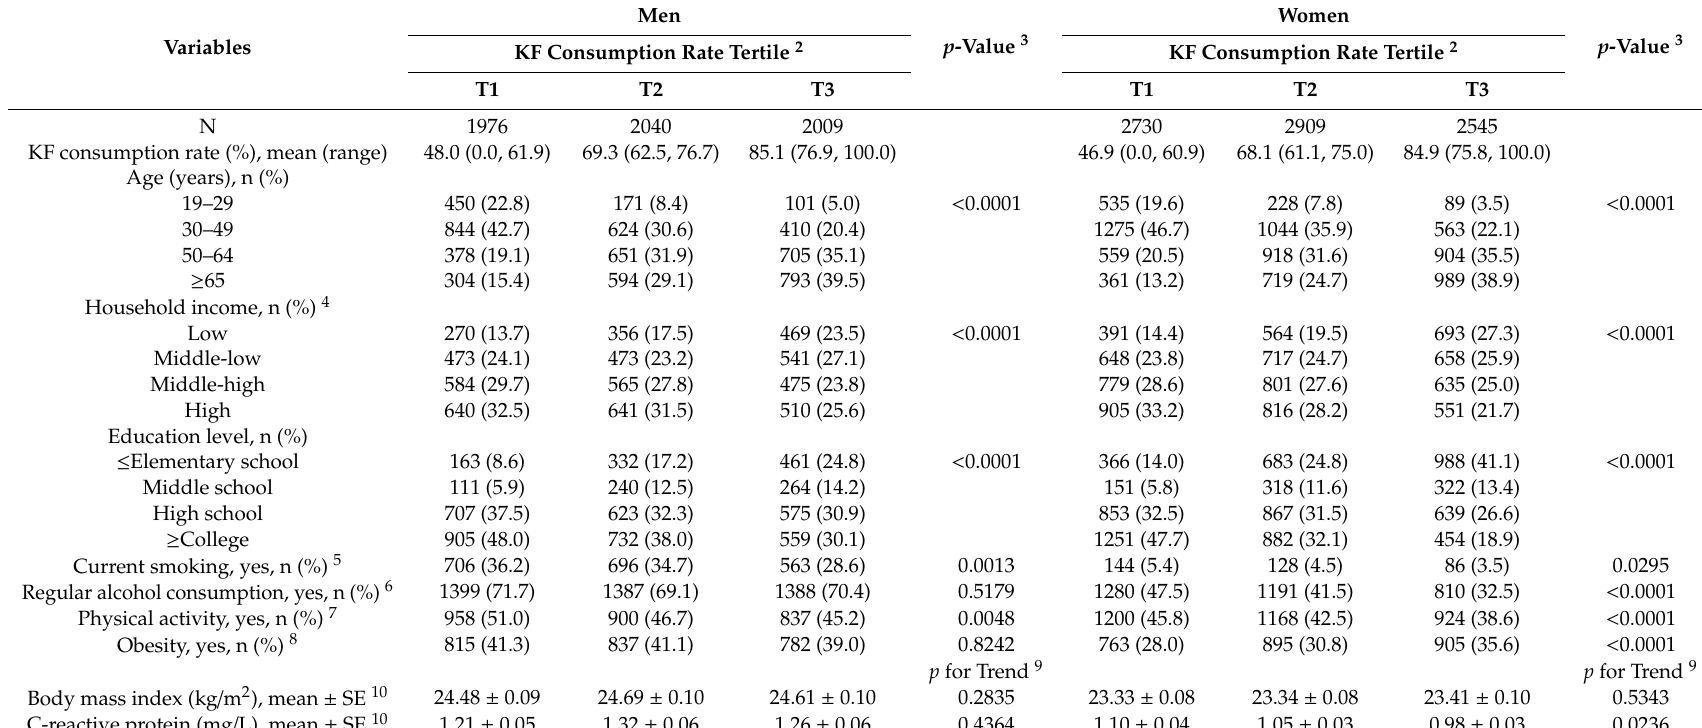
Table 2. General characteristics of subjects according to Korean food (KF) consumption rate tertile groups 1